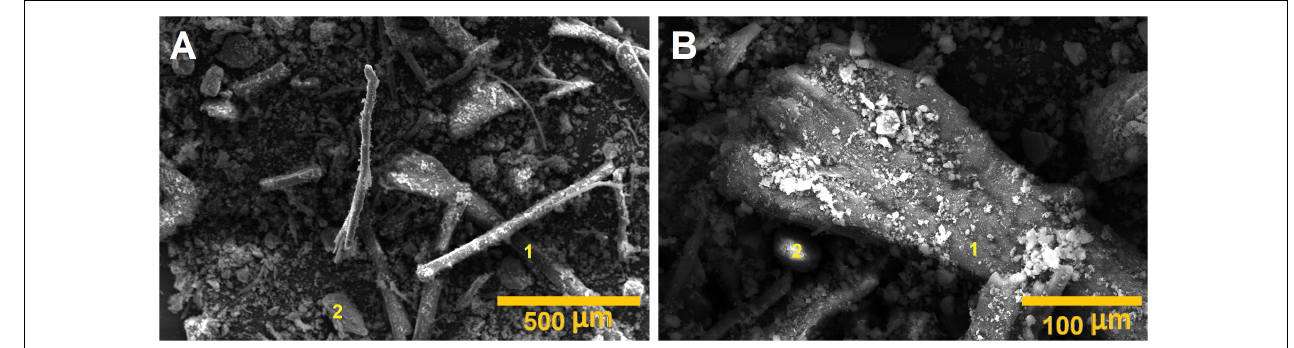
FIGURE 9 | (A) Lower magnification SEM image, and (B) higher magnification SEM image of the powdered JGC; jute fibrils (1), and the geopolymer aggregates (2).